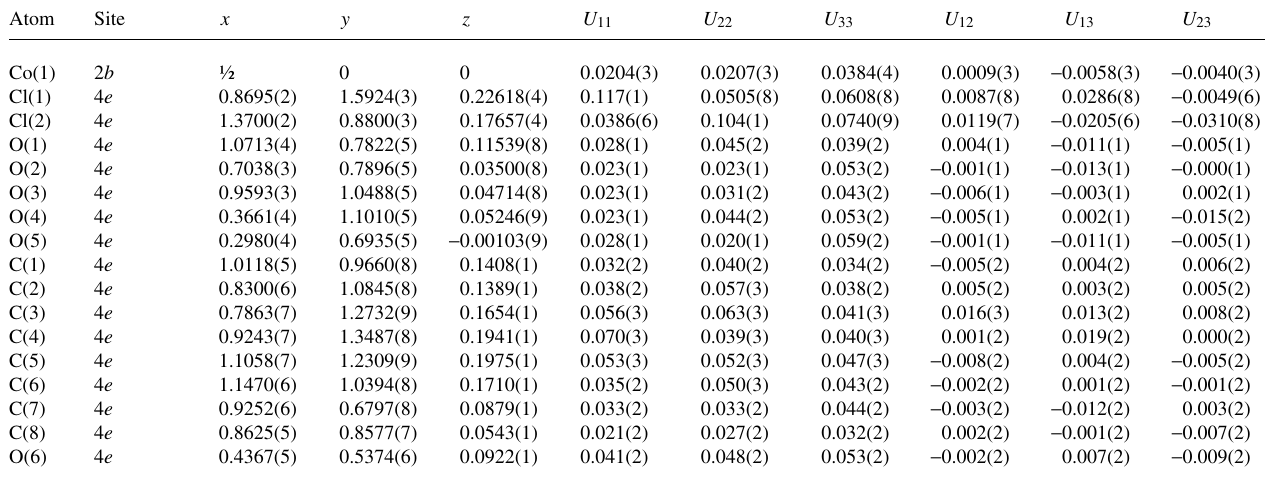
Table 3. Atomic coordinates and displacement parameters (in Å 2 )